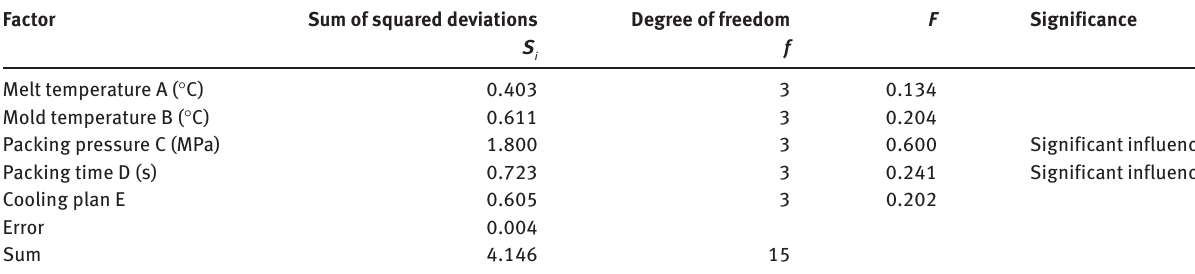
Table 8: Analysis of variance table.